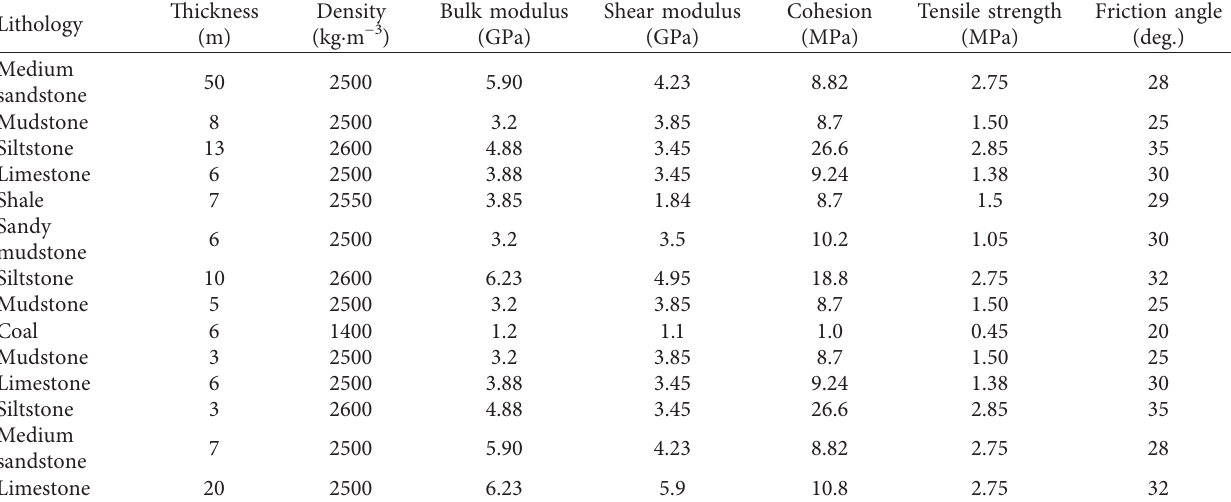
Table 3: Mechanical parameters for rock